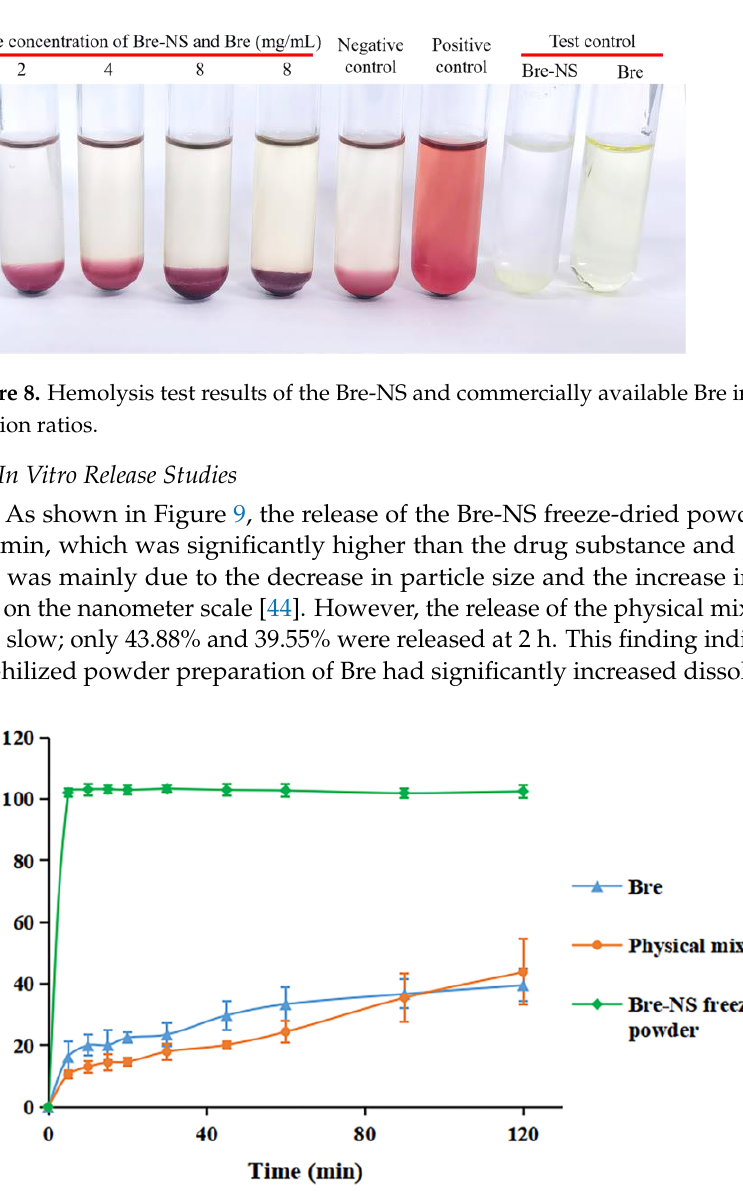
Figure 9. In vitro release curves of Bre, the physical mixture and Bre-NS freeze-dried powder.